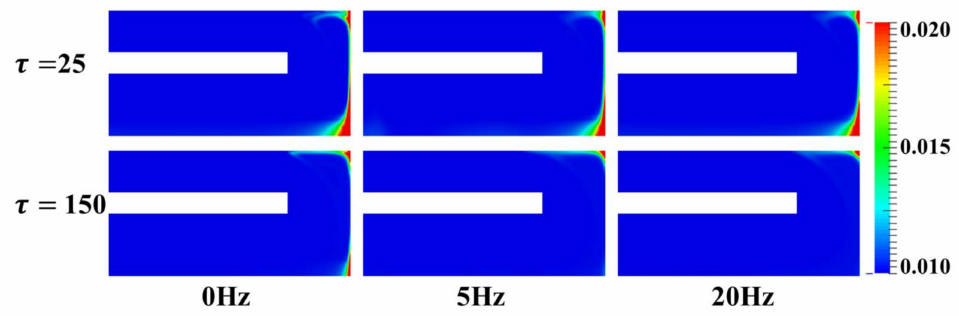
Figure 12. Nanoparticle concentration field for different pulse frequencies at τ = 25 and 150.